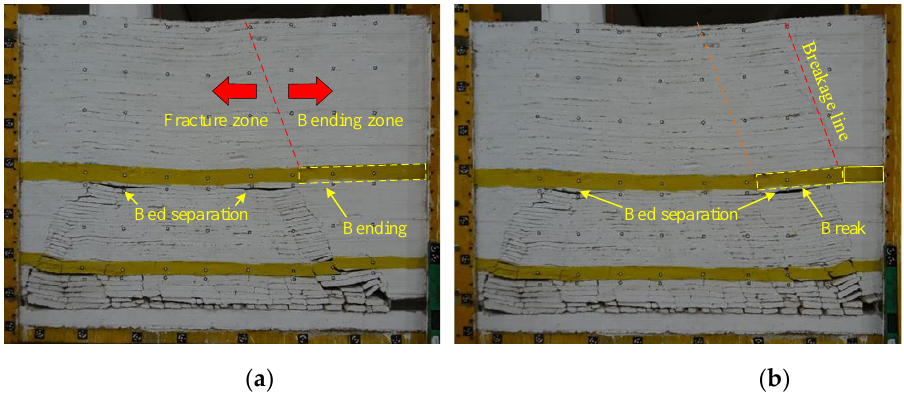
Figure 8. Breakage of the PKS. ( a ) first breaking; ( b ) periodical breaking.